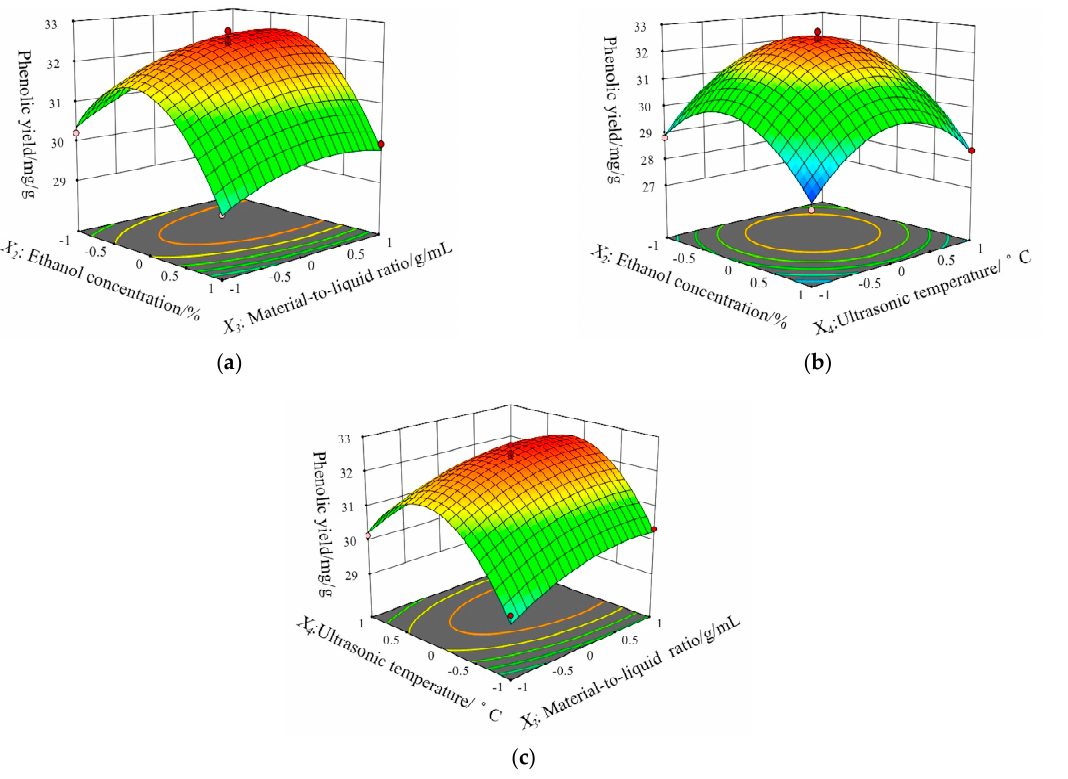
Figure 2. Response surface plots showing the effect of two of the three independent variables on the extraction yield (mg/g) of the total phenolics, the two changed variables were: ( a ) ethanol concentration and the material-to-liquid ratio; ( b ) the ethanol concentration and ultrasonic temperature; ( c ) the material-to-liquid ratio and ultrasonic temperature.